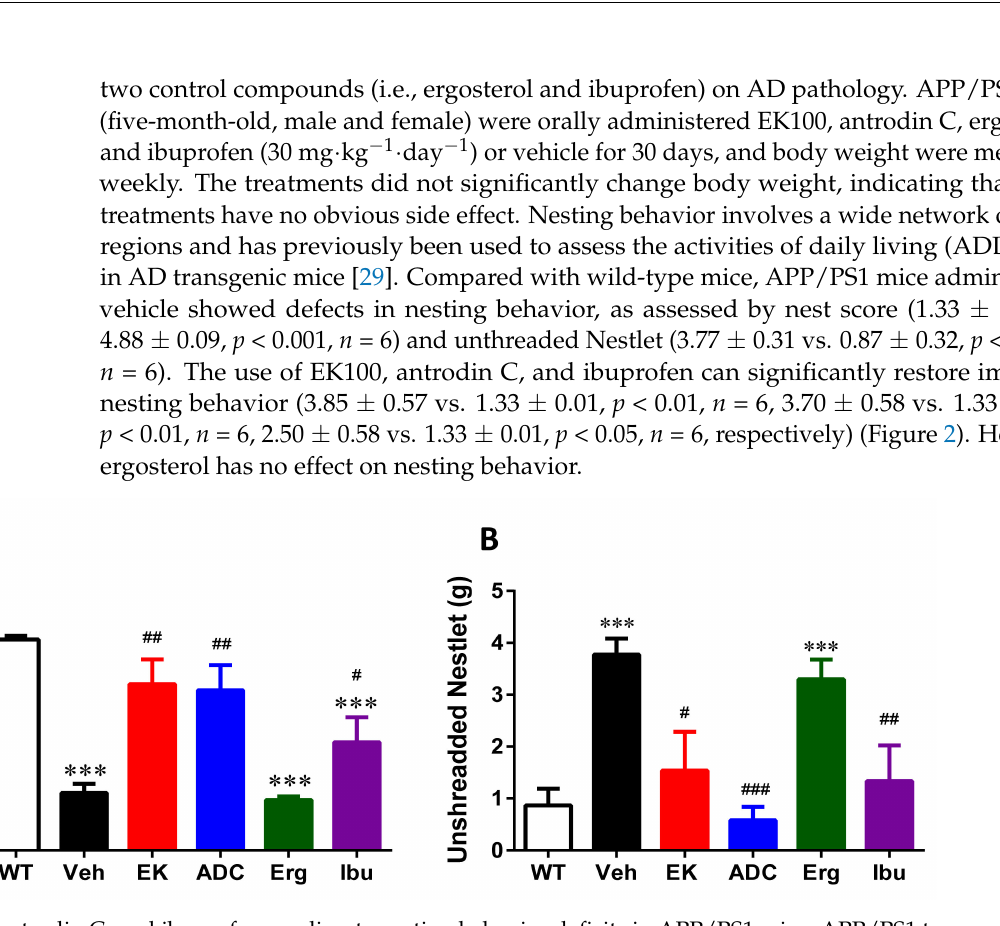
Figure 2. EK100, antrodin C, and ibuprofen ameliorate nesting behavior deficits in APP/PS1 mice. APP/PS1 transgenic mice were orally administered with vehicle (Veh) or EK100 (EK), antrodin C (ADC), ergosterol (Erg), and ibuprofen (Ibu) (30 mg · kg − 1 · day − 1 , n = 6 each). Nesting tasks were performed at 30 days post administration. The image in wild-type (WT) mice ( n = 6) is also compared. Bar graphs show the results from the nesting task’s nest score ( A ) and unshredded Nestlet ( B ) from nesting task. The results are the mean ± S.E.M. Significant differences between WT group and the other groups are indicated by ***, p < 0.001. Significant differences between Veh group and reagent-treated groups are indicated by # , p < 0.05; ## , p < 0.01; ### , p <